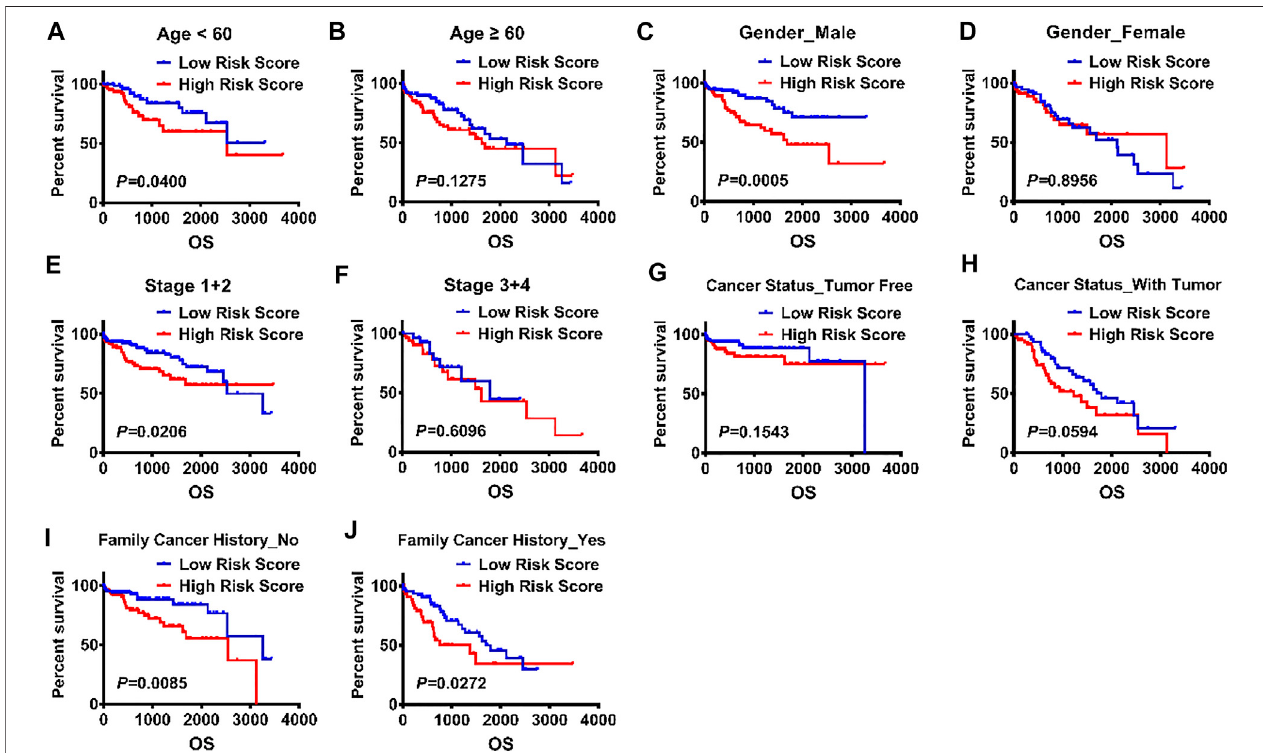
FIGURE6| ValidationoftheriskscoresforapanelofE2FtargetgenesignaturebyKMplot. (A-J) KMsurvivalanalysiswasusedtoexploretheimpactofriskscore ontheprognosisofHCCpatientsstrati fi edbytheclinicalandpathologicalparameters, including age,gender,stage, cancerstatus,familycancerhistory,andriskscore.